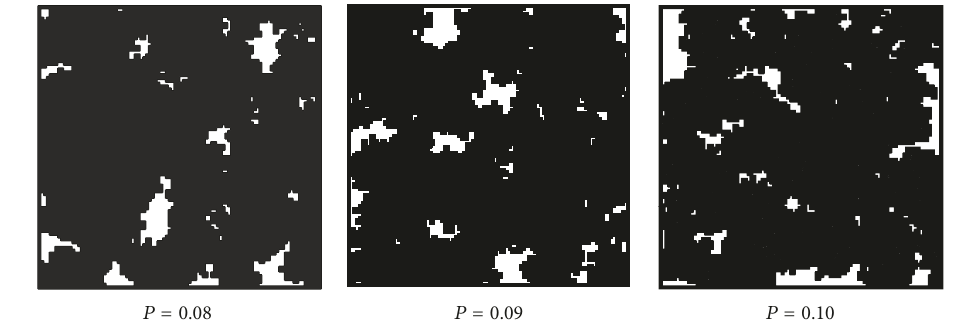
Figure 3: The real porous media model reconstructed by the improved QSGS.